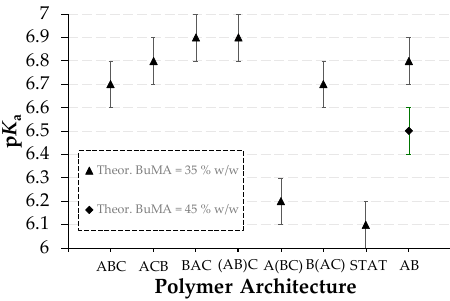
Figure 6. Effect of the polymer architecture and the theoretical hydrophobic BuMA weight percentage on the p K a .